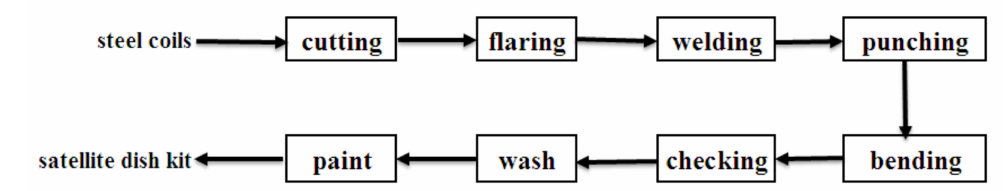
Figure 3. Process flow of satellite dish kit production line (before improvement).